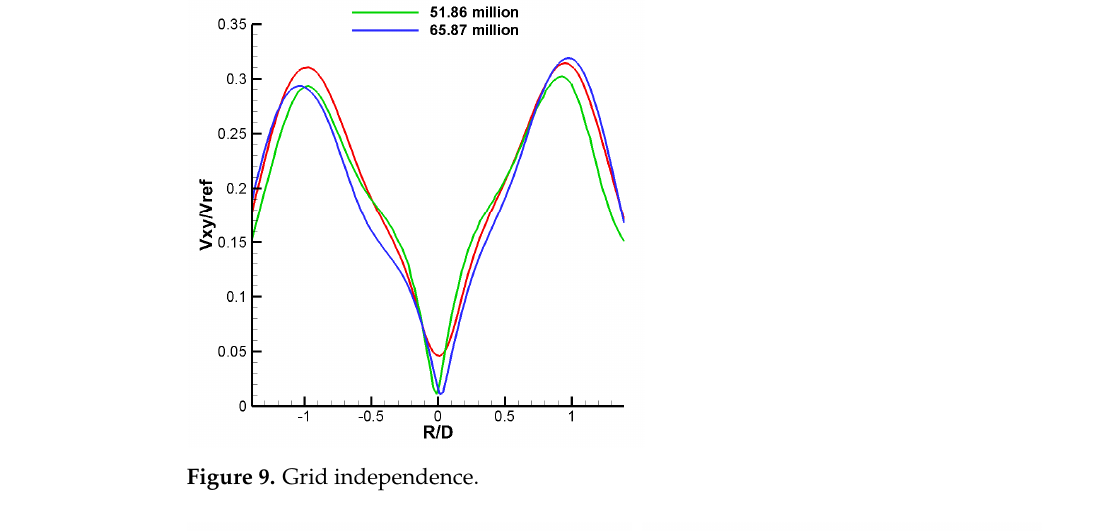
Figure 9. Grid independence.